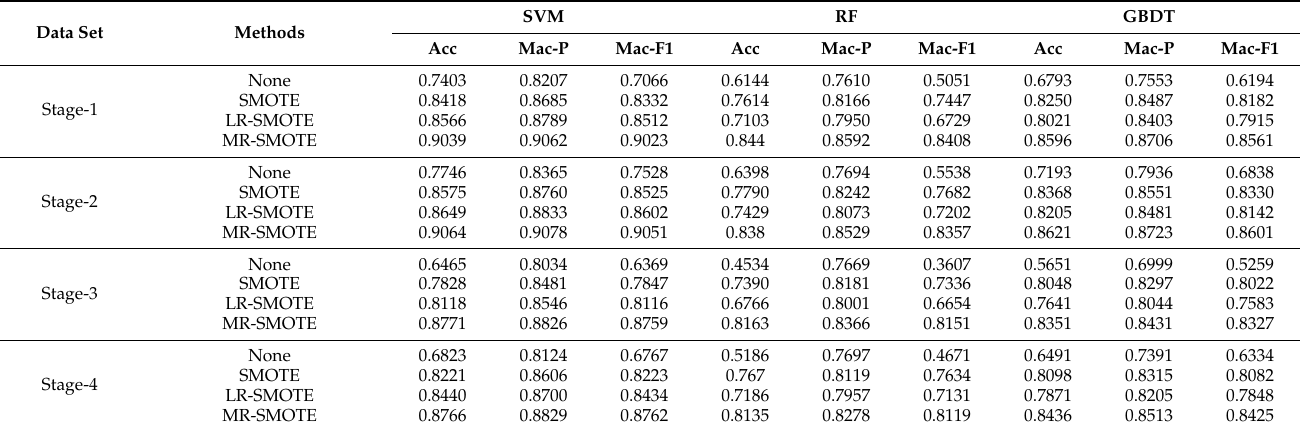
Table 7. Experimental results of the step unbalanced data